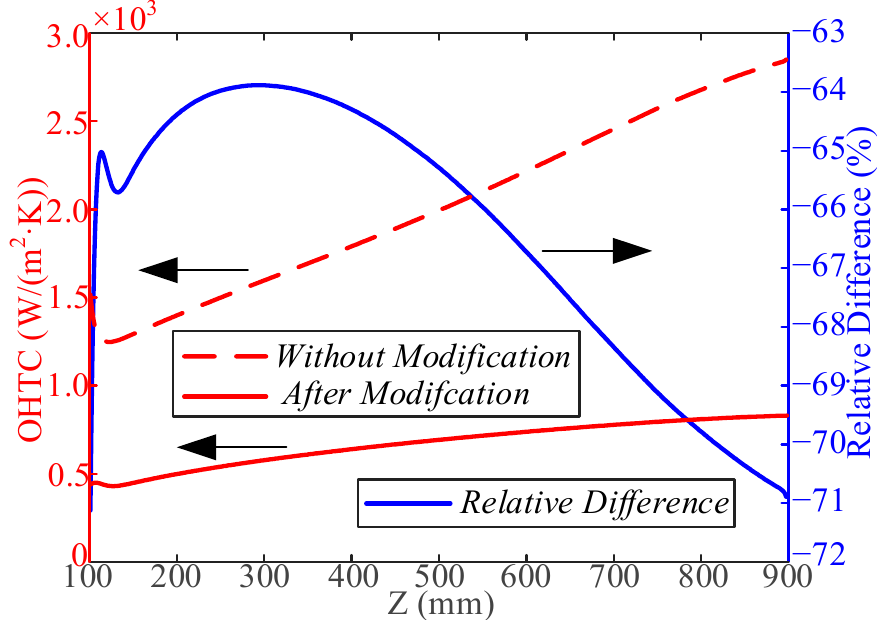
Figure 7. Comparison of the OHTC without modification and after modification.